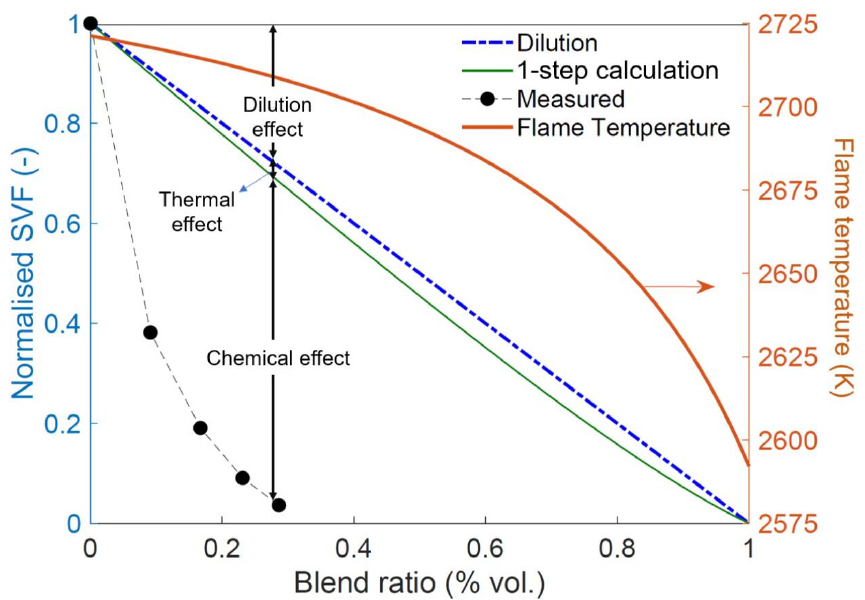
Figure 9. Normalized measured maximum soot volume fraction SVF (dots) at the flame centerline as a function of the volumetric percentage of ammonia (left axis). Calculated flame temperature (right axis). Model predictions: concentration change via dilution (blue dashed line), single-step model (green solid line).